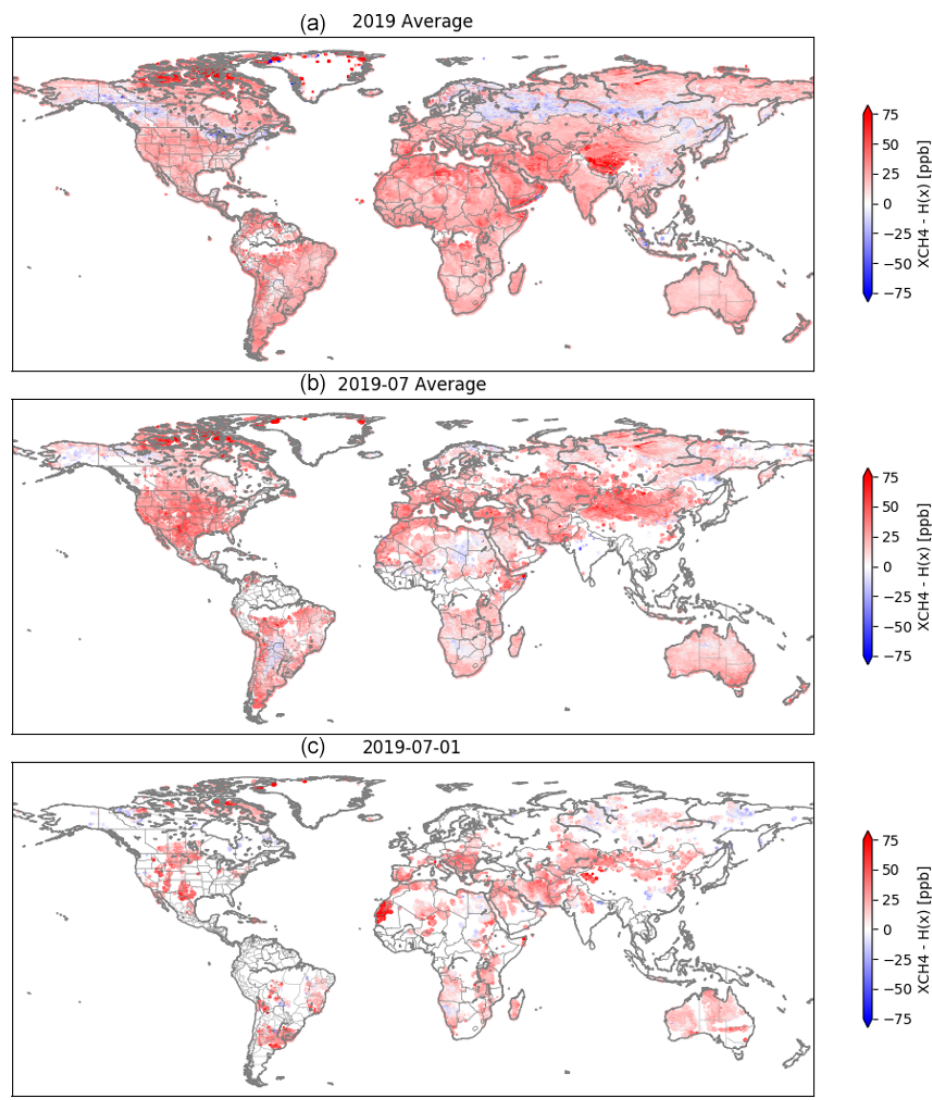
Figure 6. Departure values computed with the observations displayed in Fig. 1 for the full year 2019, July 2019 and 1 July 2019.